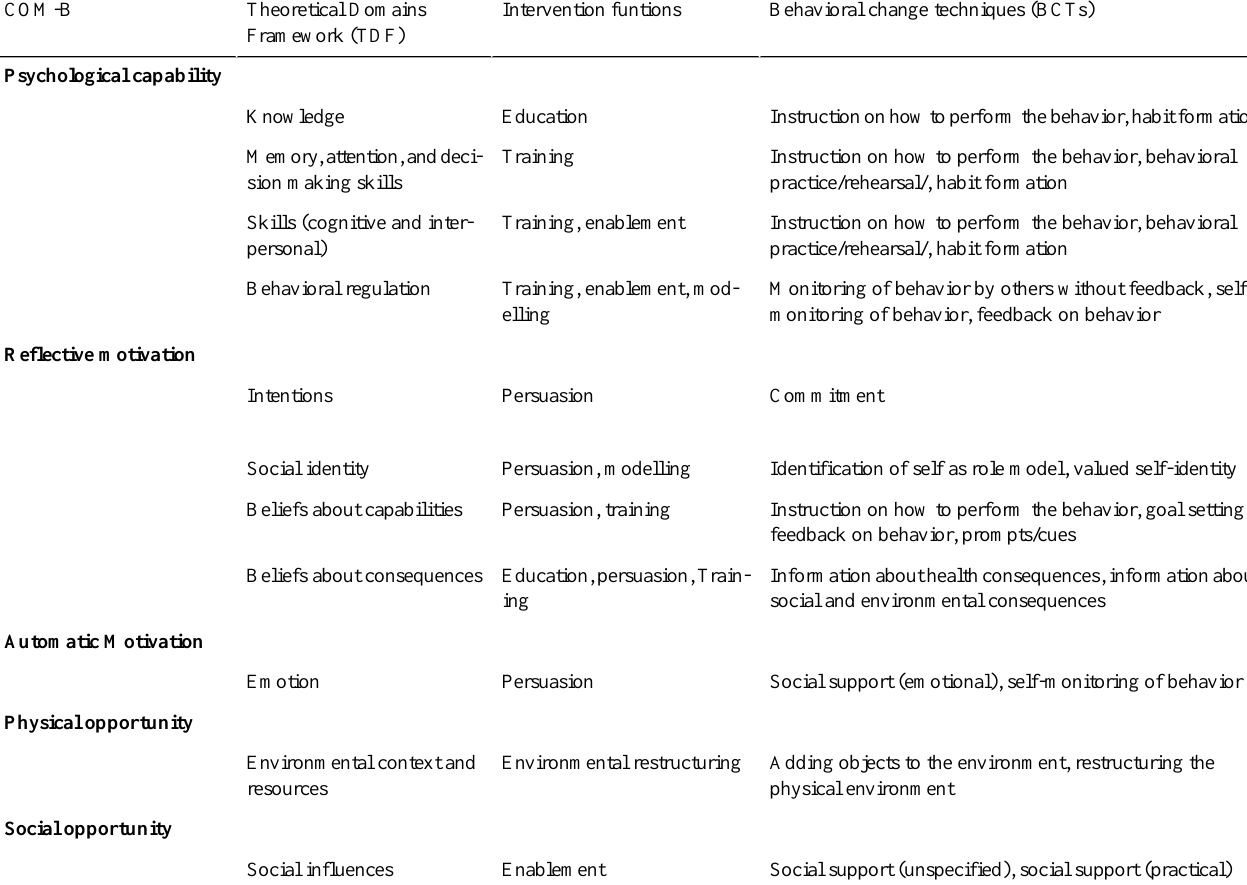
Table 4. Mapping behavioral change techniques (BCTs) to intervention functions.